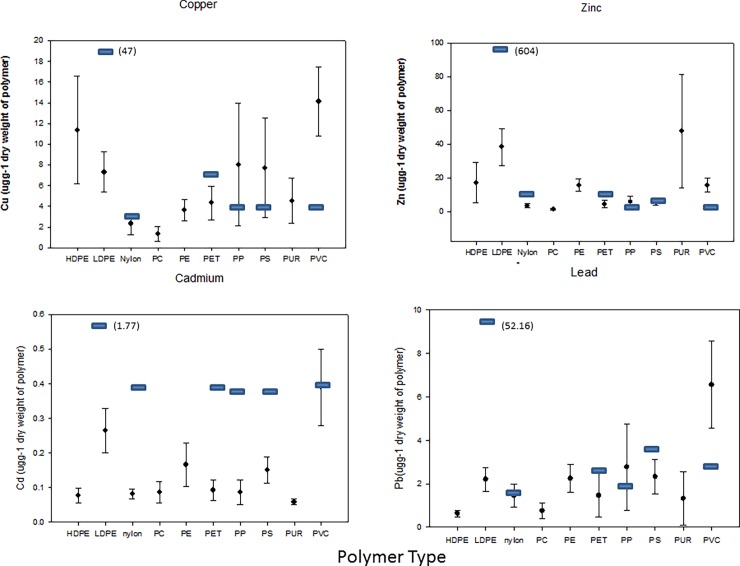
a, b, c and d. Amounts of metal extracted from 10 polymers collected from 9 urban intertidal regions, Burrard Inlet, Vancouver, B.C. Canada; a) copper, b) zinc, c) cadmium and d) lead. Values are in μgg-1 dry weight of polymer and are means with 1 standard deviation. Metals extracted from recently manufactured polymers are over-laid with blue bars for comparison. Two additional polymers were identified however; the number of samples was less than 3 so they were not included in the statistical analyses.